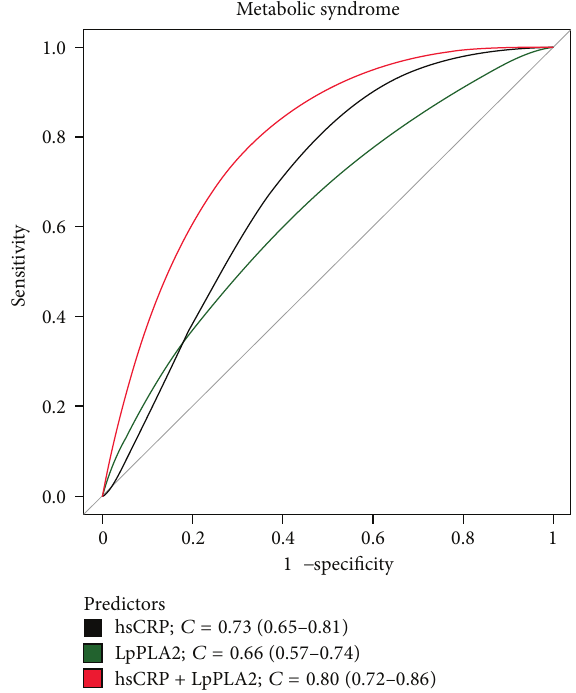
Figure 3: ROC curves for lipoprotein-associated phospholipase A2 (Lp-PLA2), high sensitivity C-reactive protein (hsCRP), and both together adjusted by age and